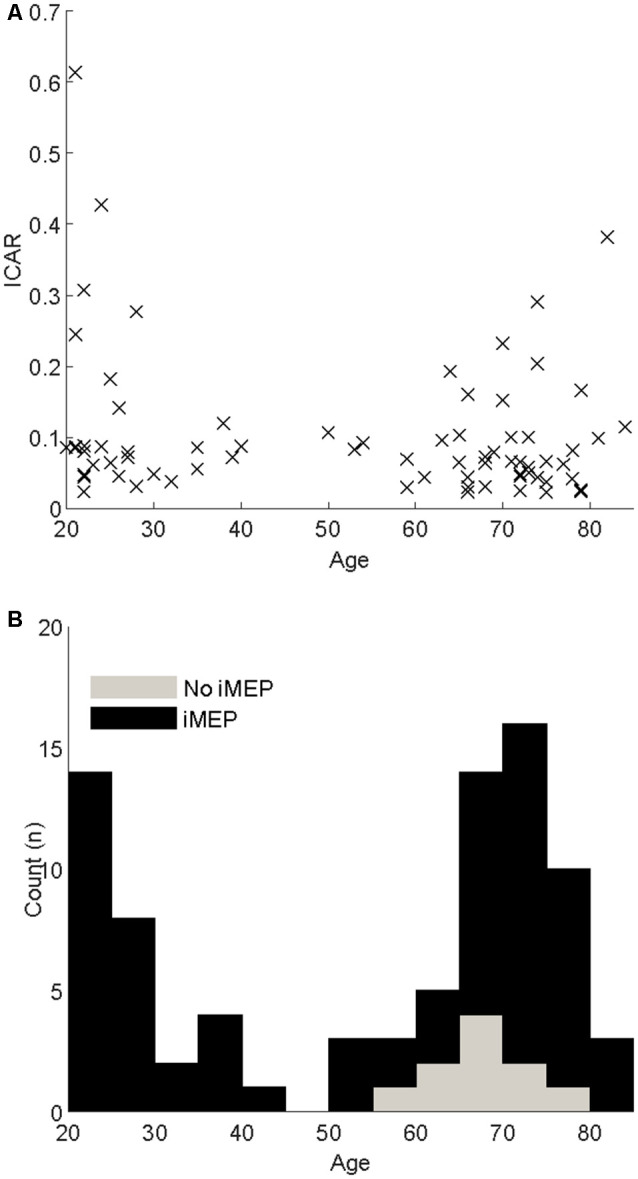
(A) Scatter of the Ipsilateral-Contralateral Amplitude Ratio (ICAR) changes with age. (B) Stacked histograms indicating the age distribution of participants. Black bars indicate participants where iMEPs were elicited; gray indicates participants without iMEPs.